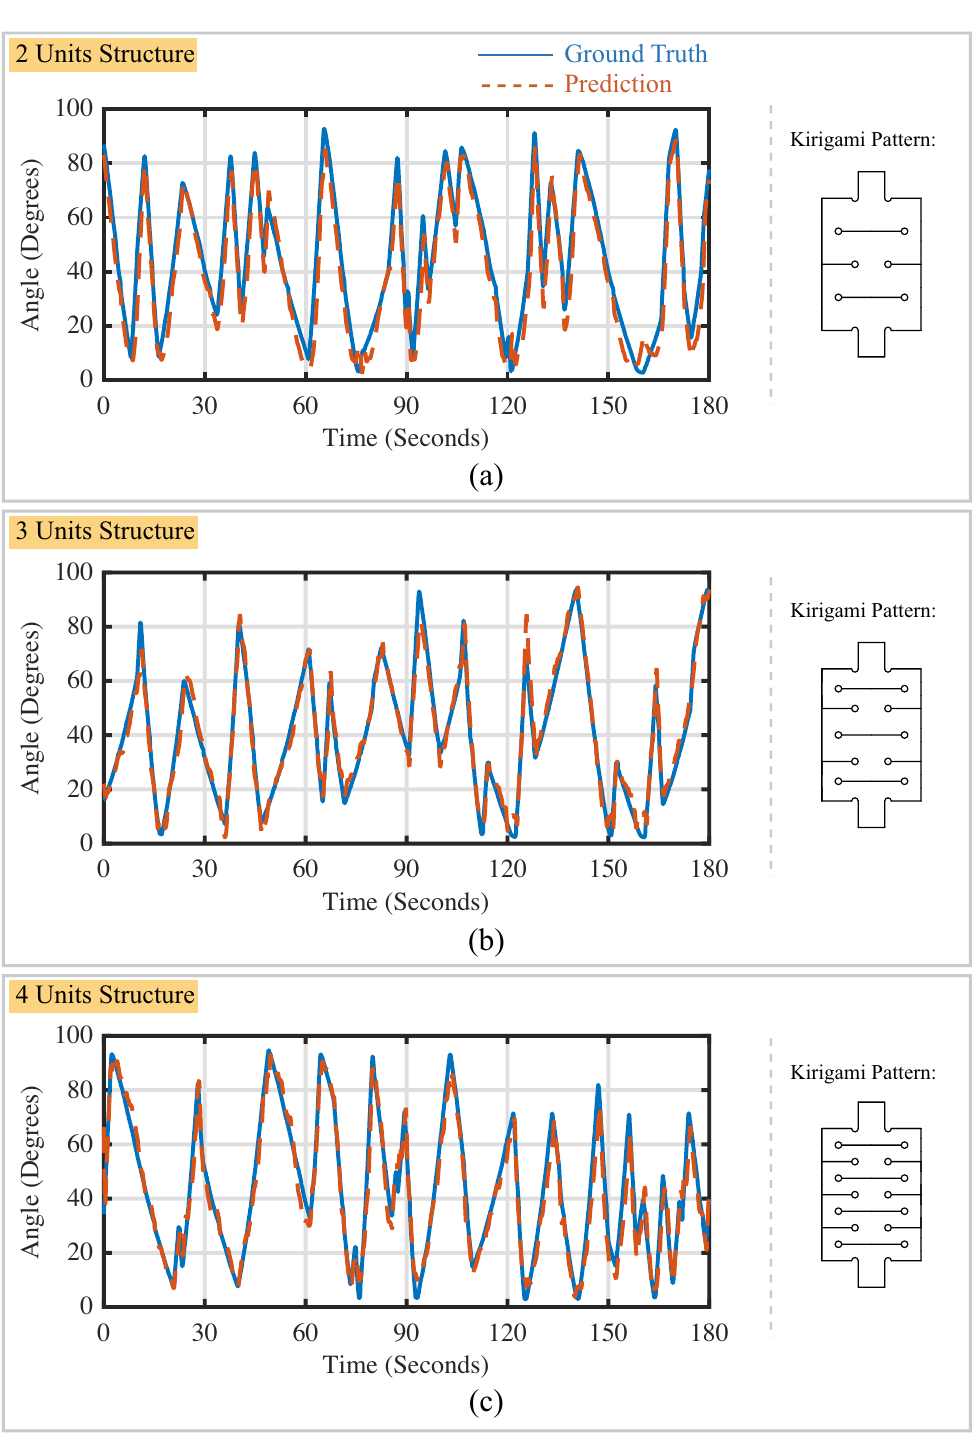
Figure 11. Performance of the LSTM calibration neural network in predicting the random motion of soft actuators. ( a ) Results for sensors with two-unit structure; ( b ) results for sensors with three-unit structure; ( c ) results for sensors with four-unit structure. Ground truth is indicated using a solid line. Prediction results are indicated using a dashed